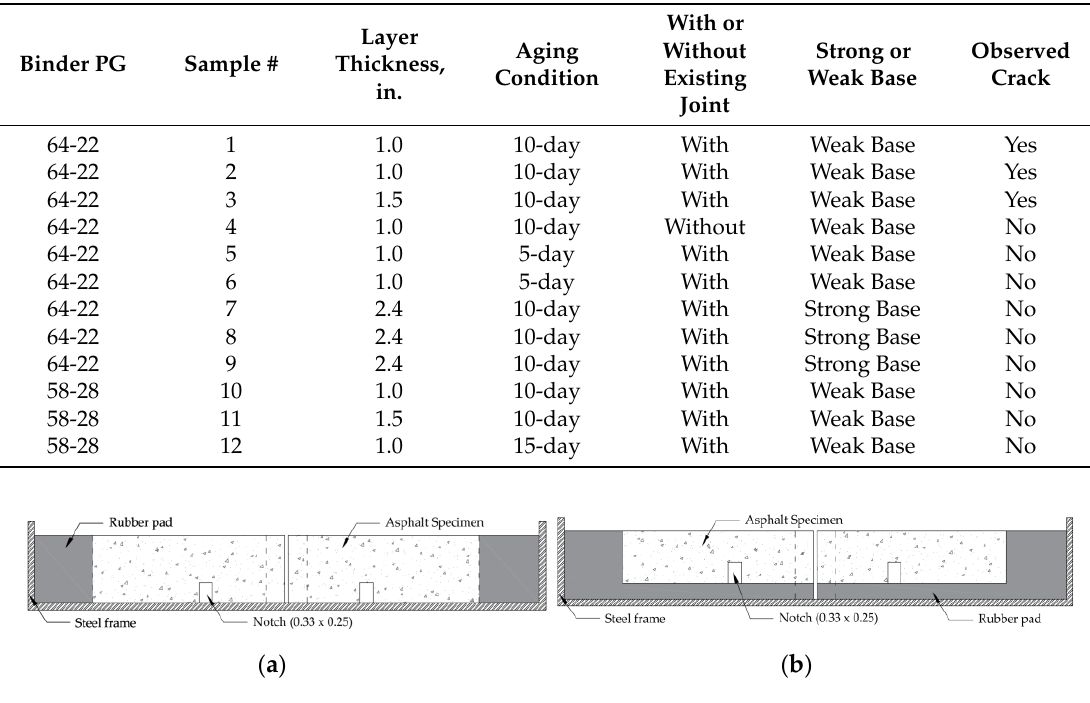
Figure 2. Cross-sectional detail of Hamburg wheel-tracking device (HWTD) cut from the center with mold and specimen assembly. ( a ) Specimen with a strong base placed directly on top of an HWTD steel frame ( b ) specimen with a weak base placed on top of the rubber. Table 2. Design of test condition.